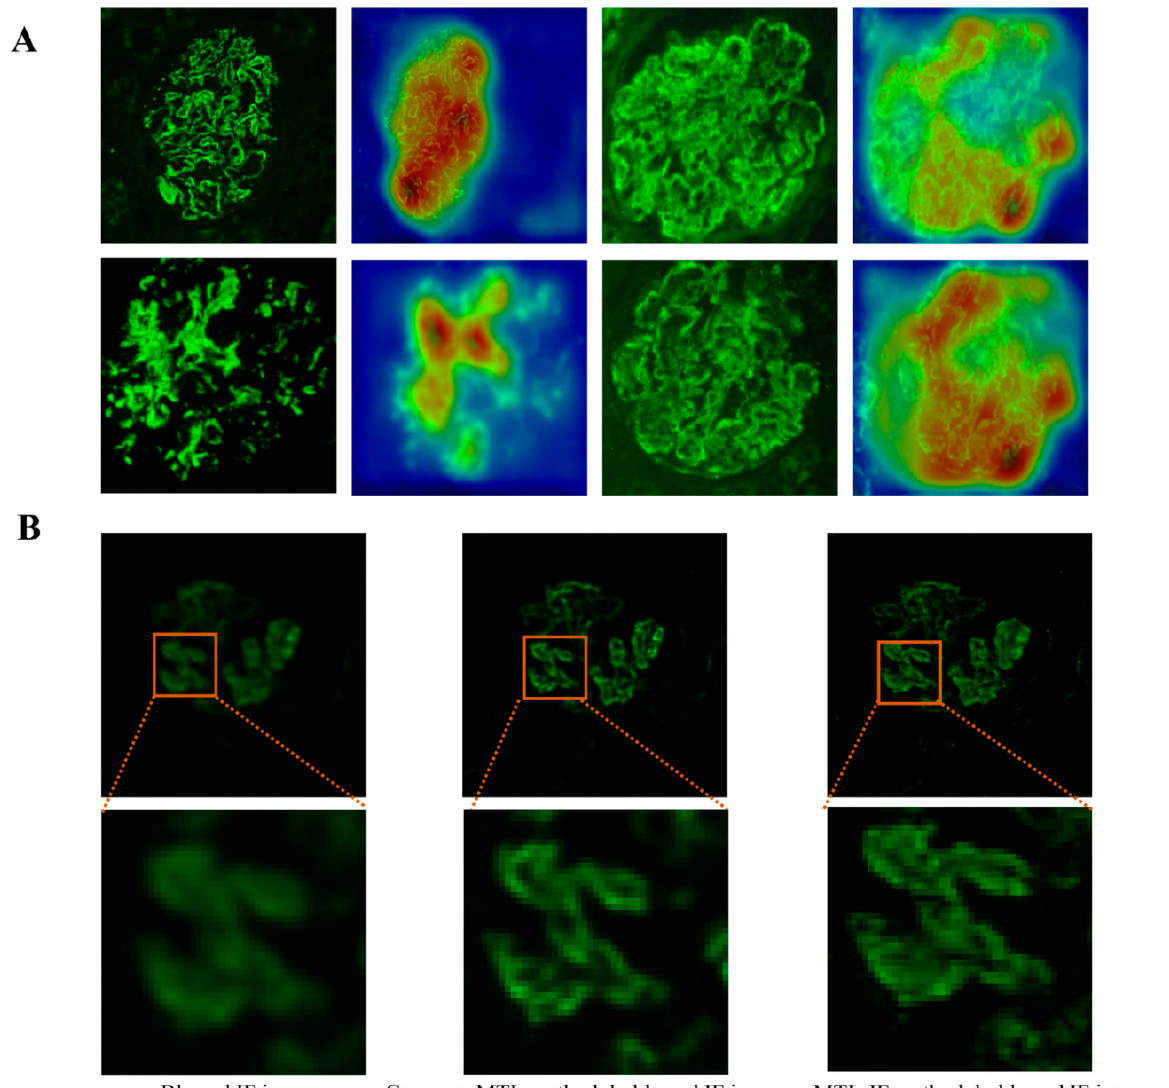
Figure 2. ( A ) The heat maps of IF images. ( B ) The de-blurred images generated by the common MTL method and the MTL-IF method, including the blurred IF image, common MTL method de-blurred IF image, and MTL-IF method de-blurred IF image.